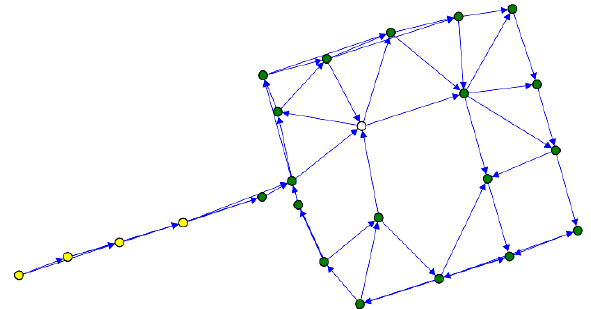
Figure 6. Case Study 1: datum-dependent quality measures after block adjustment.